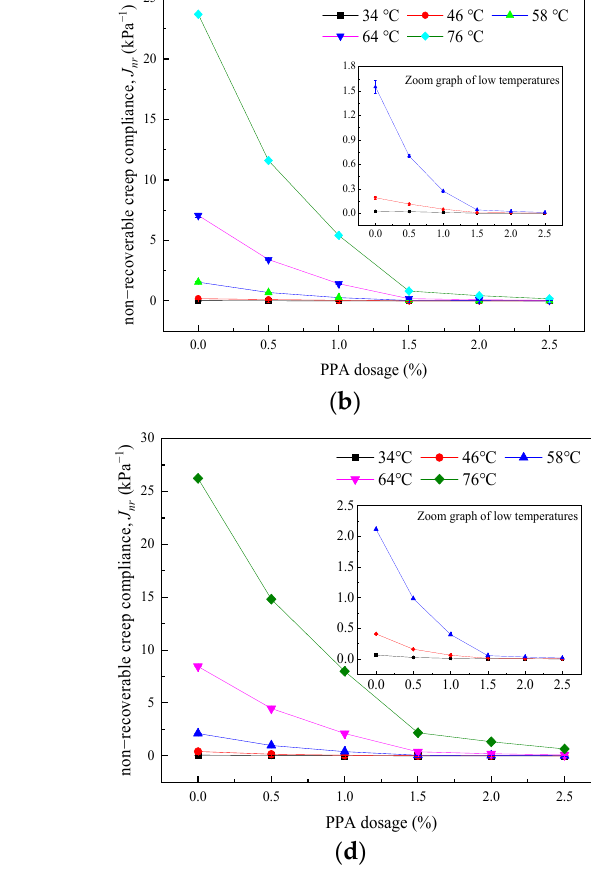
Figure 4. Calculation results of R and J nr ( a ) R ( 0.1 ) ( b ) J nr ( 0.1 ) ( c ) R ( 3.2 ) ( d ) J nr ( 3.2 ) .